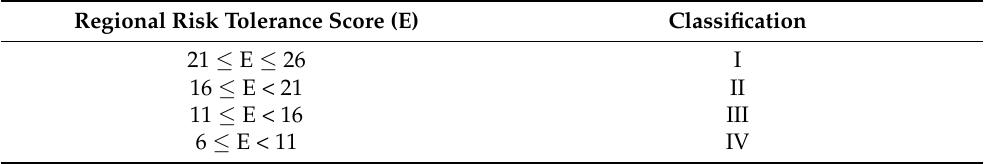
Table 4. Classification of regional risk tolerance.